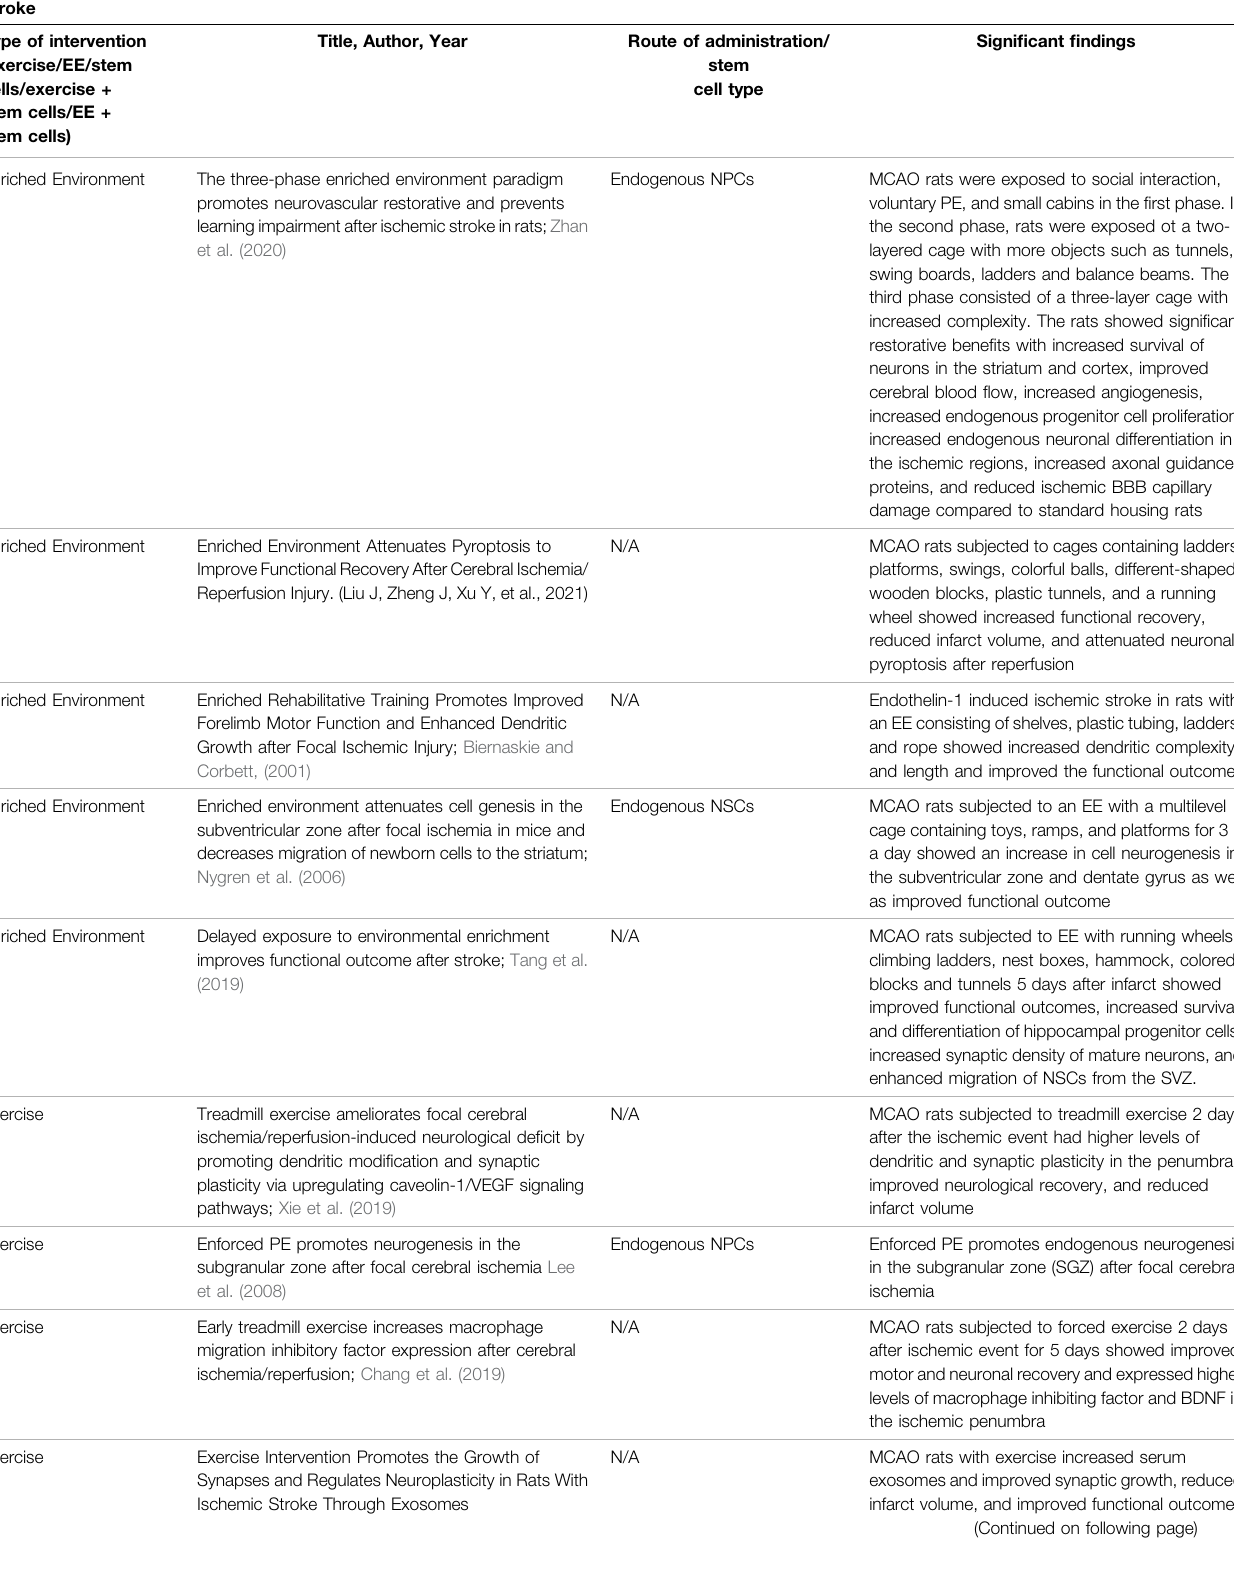
TABLE 3 | Experimental studies for stroke with stem cell transplantation, an enriched environment, exercise, and a combination of enriched environment or exercise with stem cells.